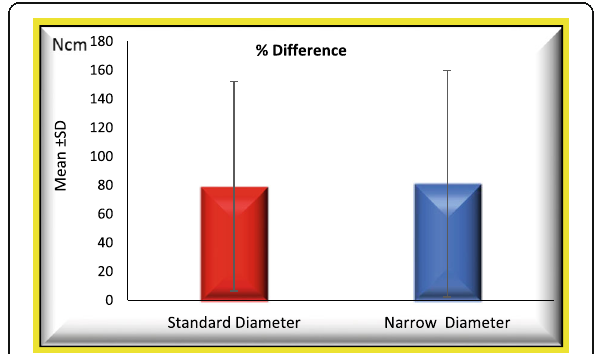
Fig. 6 Mean of percentage difference between initial and post load